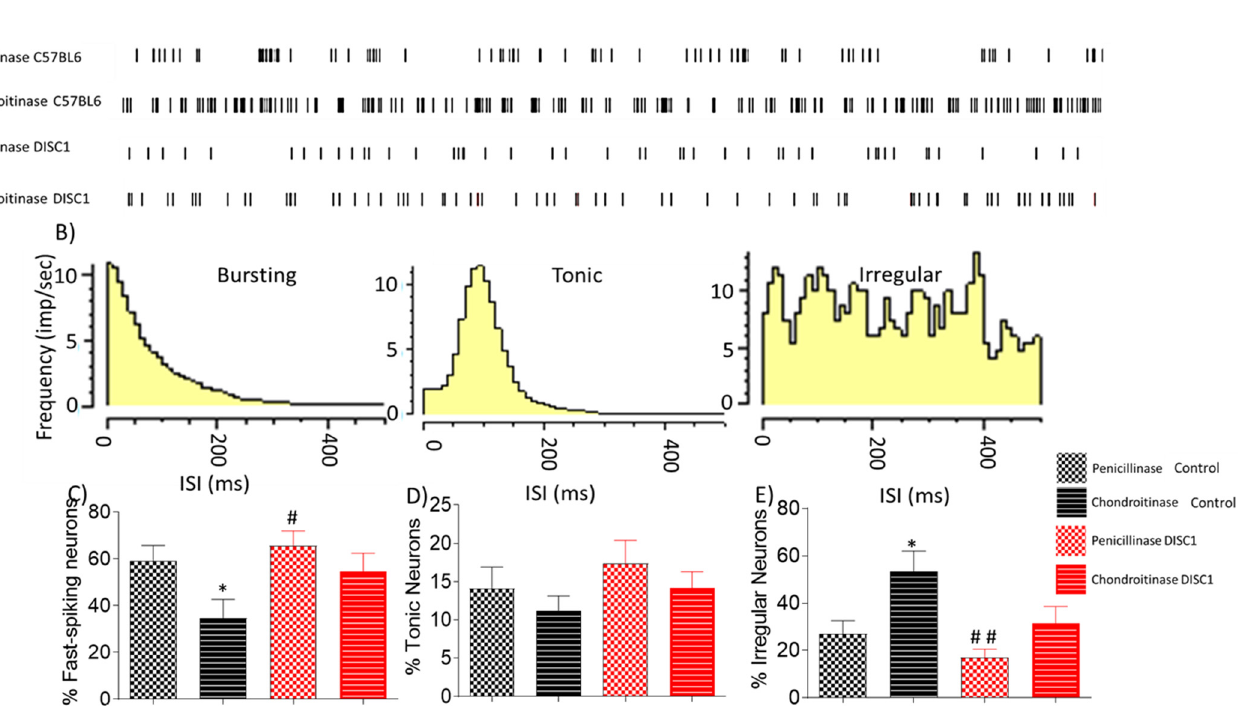
Figure 5. Electrophysiological classification of neural changes after chondroitinase or penicillinase treated animals as determined by extracellular recording of spontaneous neuronal activity in the PFC. ( A ) example firing patterns of sponta- neously recorded neurons in different groups; ( B ) characteristic frequency for bursting, tonic, and irregularly firing neurons; ( C – E ) percent distribution of types pf neurons as recorded spontaneously from PFC of animals, i.e. fast spiking, tonic and irregularly firing neurons respectively. The data are shown as mean ± s.e.m. where * or # p ≤ 0.05, ## p ≤ 0.01, where the symbols express the comparison of chDISC1 mutation animals with * represents comparison vs. penicillinase control and # represents comparison vs. chondroitinase control.